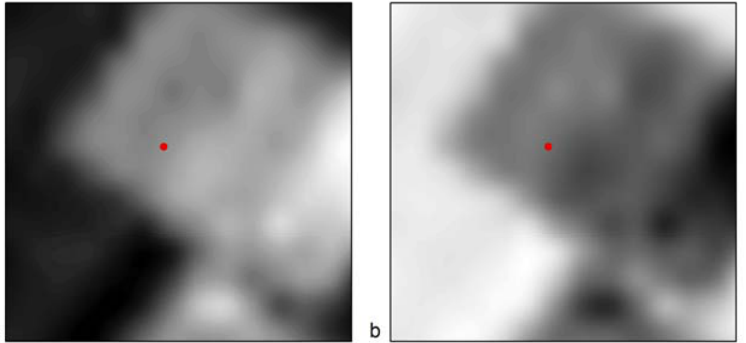
Figure 9. Landsat multispectral images used for the detection of the neolithic tell Melia 2 (indicated with a red spot) at the Thessalian plain, after the application of broadband indices: ( a ) EVI and ( b ) Green